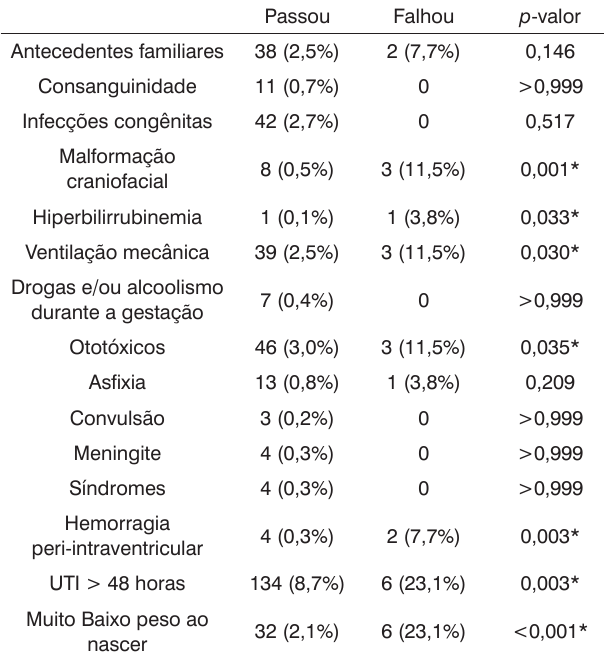
Tabela 3. Resultado da TAN segundo os indicadores de risco analisados.